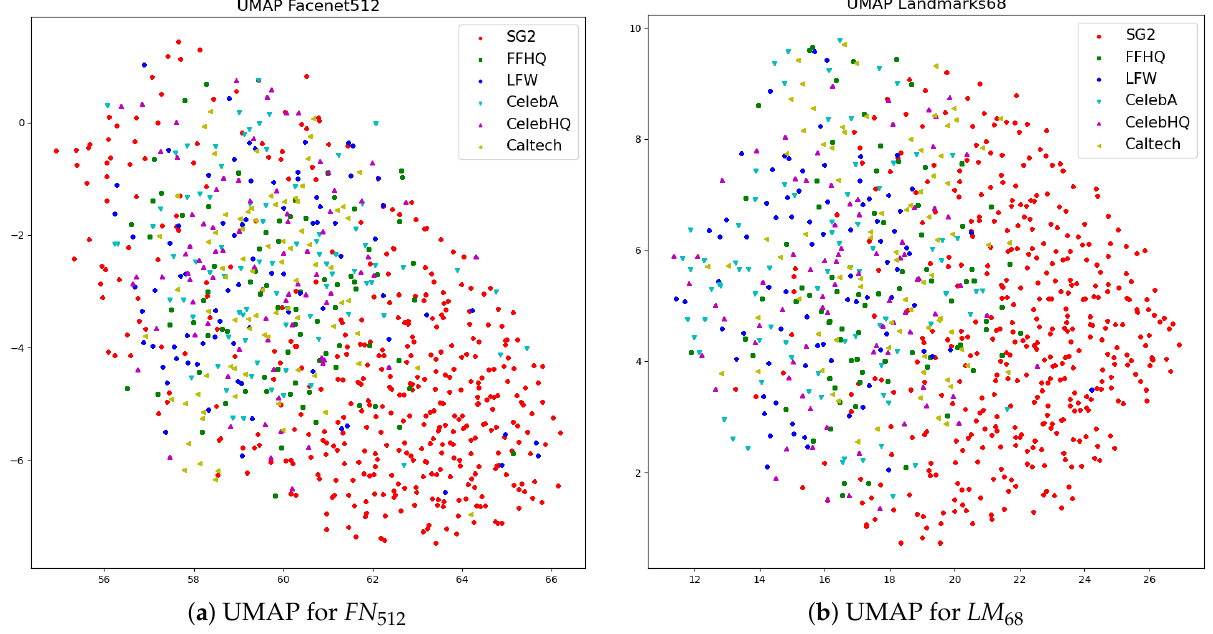
Figure 10. Visualization of FN 512 and LM 68 differential feature vectors through the UMAP dimen- sionality